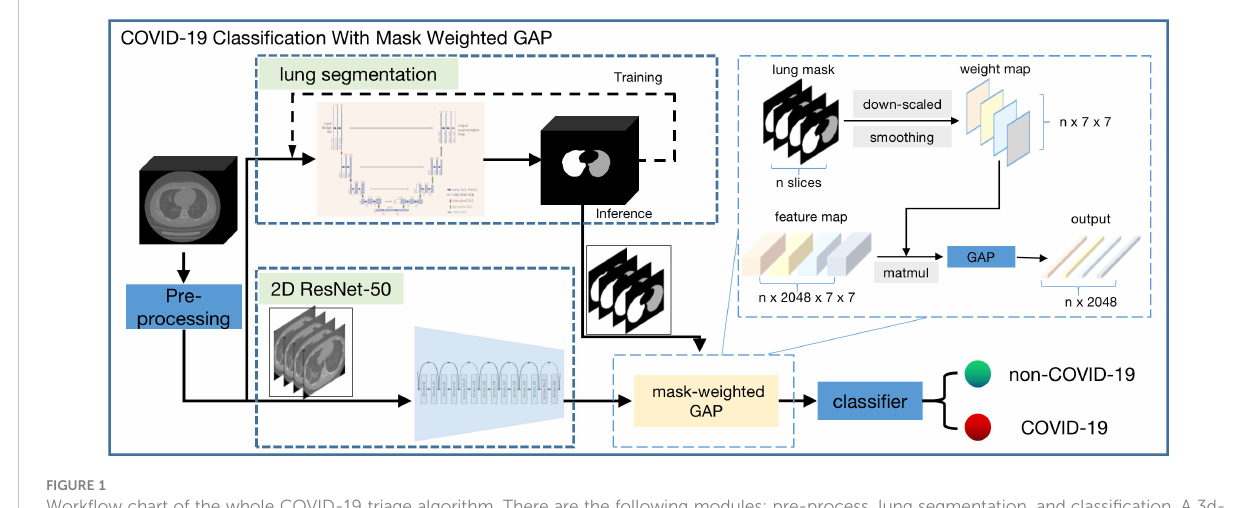
FIGURE 1 Work fl ow chart of the whole COVID-19 triage algorithm. There are the following modules: pre-process, lung segmentation, and classi fi cation. A 3d- Unet model was used for lung segmentation and the input of this module is the isotropic volume after pre-process module. The cropped isotropic image by the lung mask region is the input of classi fi cation module. Before the classi fi er, a weight-mask GAP is applied to the feature maps extracted by resnet-50